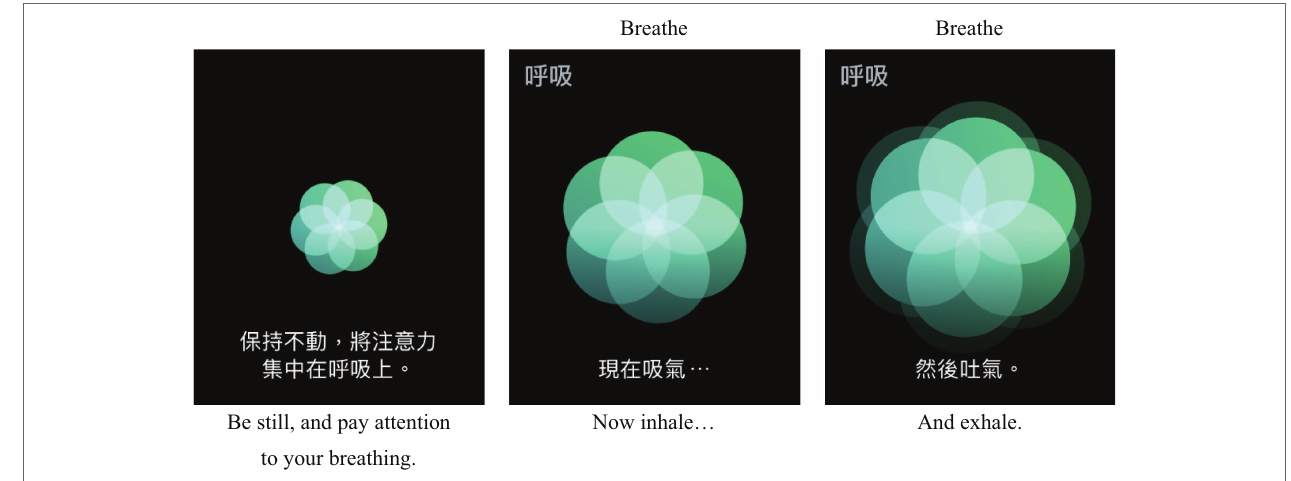
FIGURE 1 | Operation